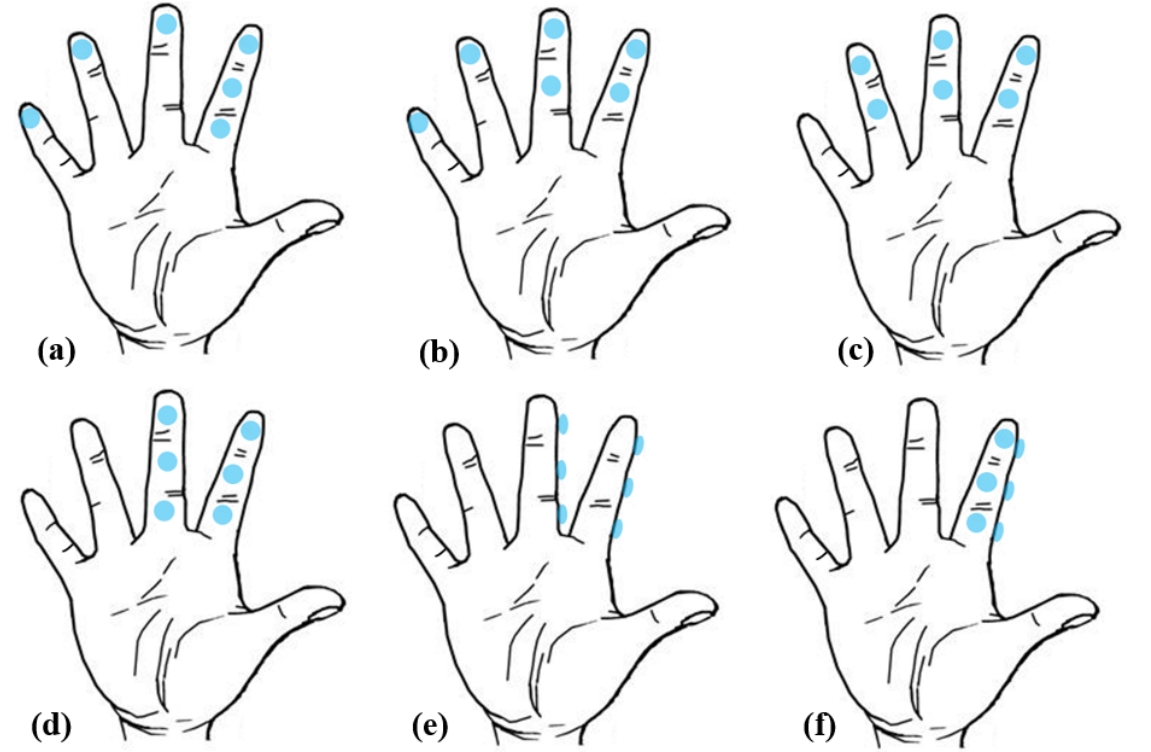
Figure 9. The different placement modes of pressure sensors. ( a ) Type 1; ( b ) Type 2; ( c ) Type 3; ( d ) Type 4; ( e ) Type 5; ( f ) Type